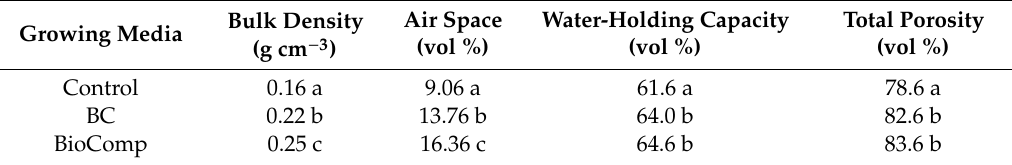
Table 2. Physical properties of formulated three growing